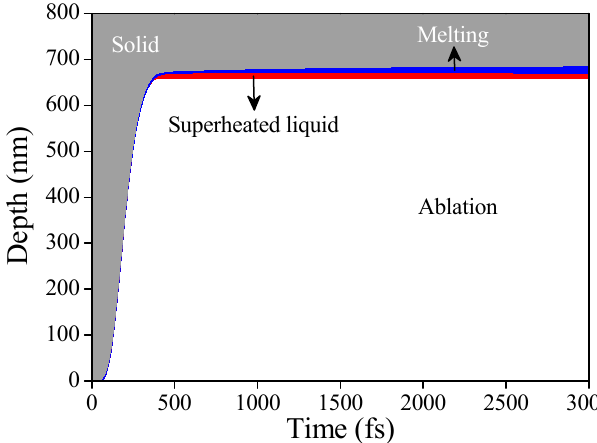
Figure 9. The ablation depth, the superheated liquid layer and the melting layer as a function of time ( F fluence = 20 J/cm 2 ).